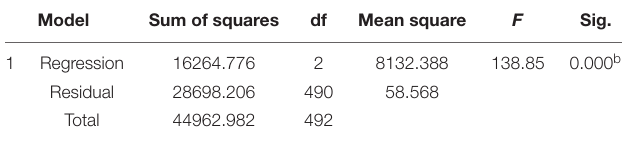
TABLE 7 | ANOVA for SEC, grit, and SAE.